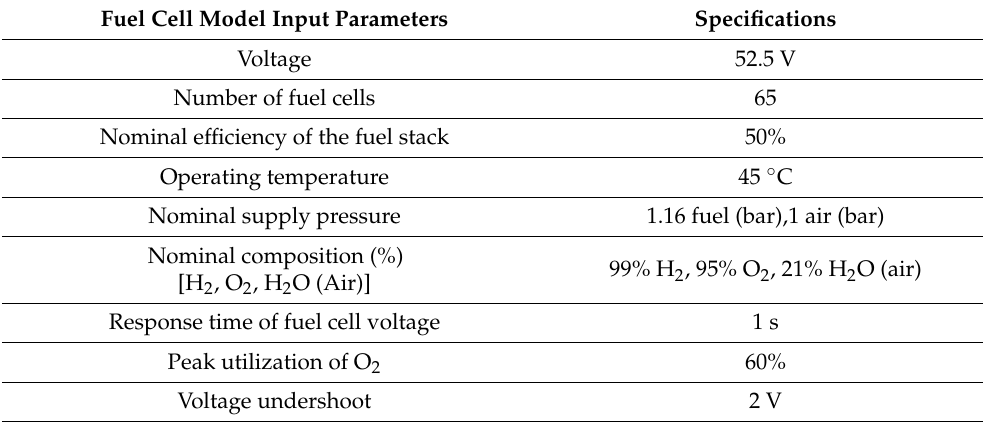
Table 1. Specifications of a fuel